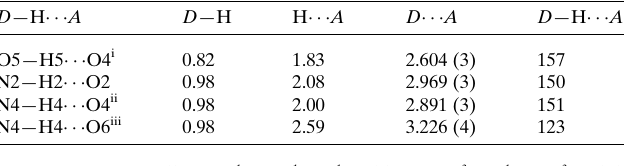
Table 2 Hydrogen-bond geometry (A˚ , (cid:4) ) for I